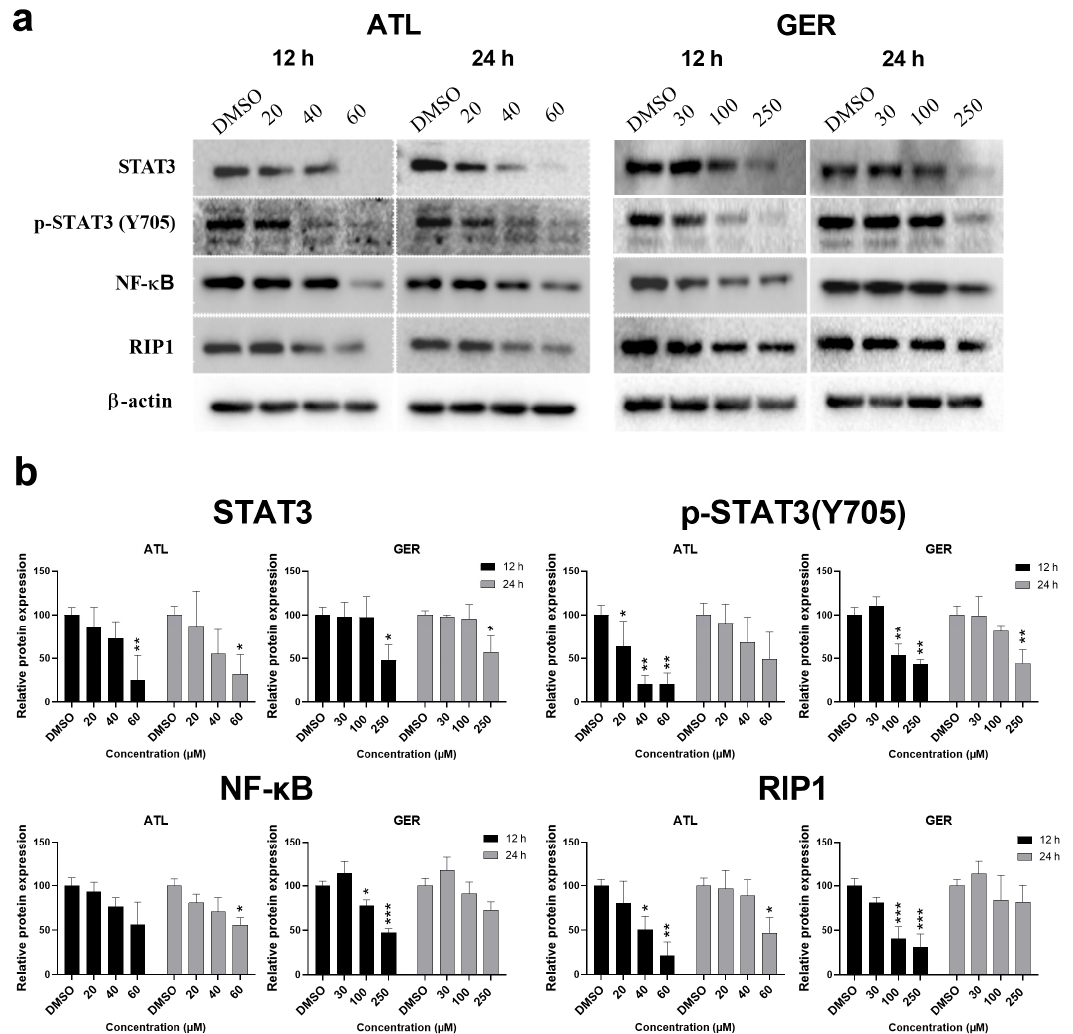
Figure 2. Western blot analysis of transcription factors STAT3 and NF- κ B and RIP1 kinase. ( a ) Representative western blots showing expression changes in the studied proteins after ATL and GER treatment. ( b ) Relative protein expression changes in the studied proteins to β -actin. Results are expressed as the mean ± SD from three independent experiments. Results statistically significant: p < 0.05 (*), p < 0.01 (**), p < 0.001 (***).